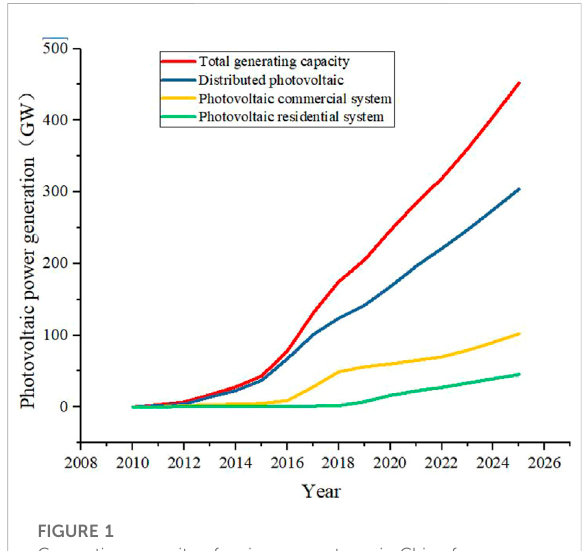
FIGURE 1 Generation capacity of various pv systems in China from 2010 to